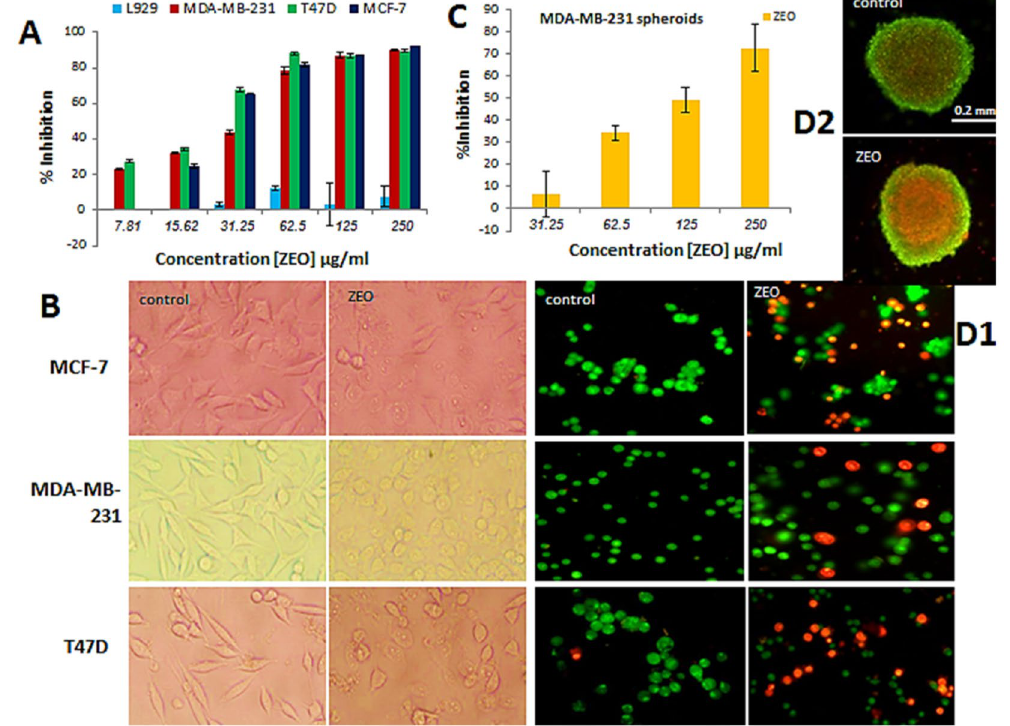
Figure 3. Inhibition of cellular viability by ZEO in monolayer and spheroid cell cultures. ( A ) L929, MCF-7, MDA-MB-231, and T47D cells were cultured in 96-well plates and treated with (7.81–250 μ g/ml) concentrations of ZEO for 48 h and viability was determined by MTT assay. ( B ) Morphological changes of MCF-7, MDA-MB-231 and T47D Breast cancer cells after 24 h incubation with IC50 concentration of ZEO imaged by invert microscope. ( C ) MDA-MB-231 cell spheroids were exposed to 31.25–250 μ g/ml concentrations of ZEO for 48 h and inhibition rate was determined by MTT assay. ( D1 , D2 ) AO/EB viability staining assay. MCF-7, MDA-MB-231, T47D 2D and MDA-MB-231 3D cell cultures after 24 h treatment with IC50 concentration of ZEO and staining with AO/EB showed clear apoptotic morphological changes in cells. Image of spheroid treated with ZEO indicates that it is not as compact as the control, suggesting spheroid integrity and size may have compromised by